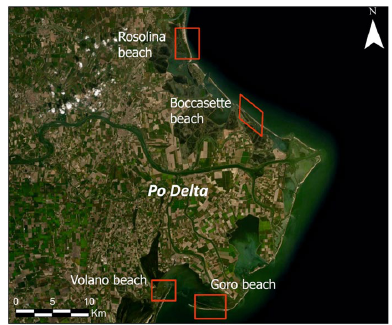
Figure 1. Location of sampling sites in the study area.